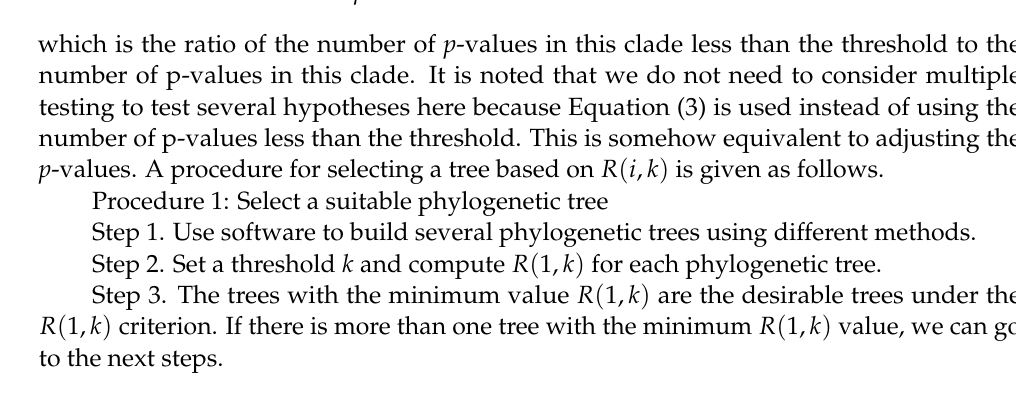
Procedure 1: Select a suitable phylogenetic